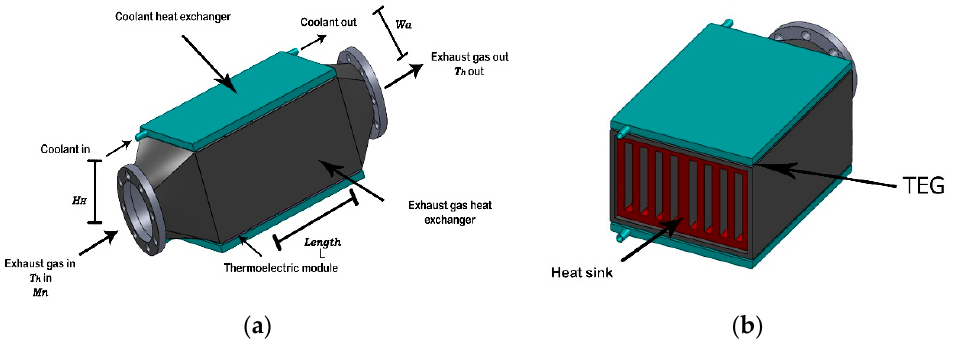
Figure 1. Three-dimensional model of the proposed system: ( a ) thermoelectric generator (TEG) whole system; ( b ) cutaway view of the proposed system.